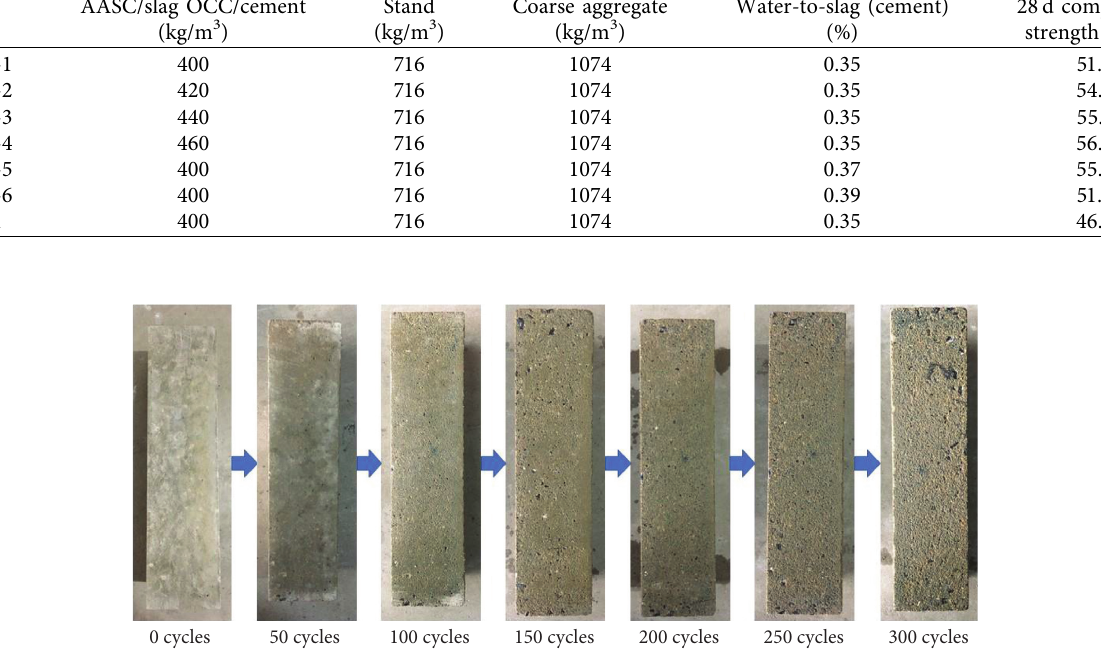
Figure 1: AASC-1 surface morphology after the freeze-thaw cycle.